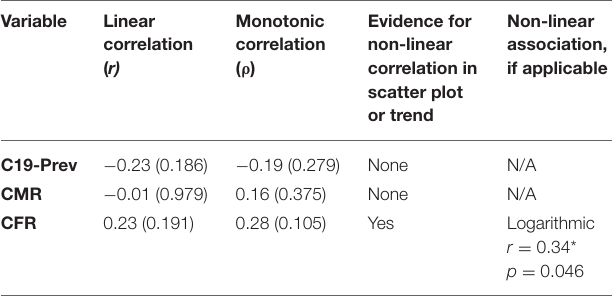
TABLE 1 | Linear and non-linear relationships between COVID-19 severity indices and the estimated prevalence of PTSD symptoms by country.